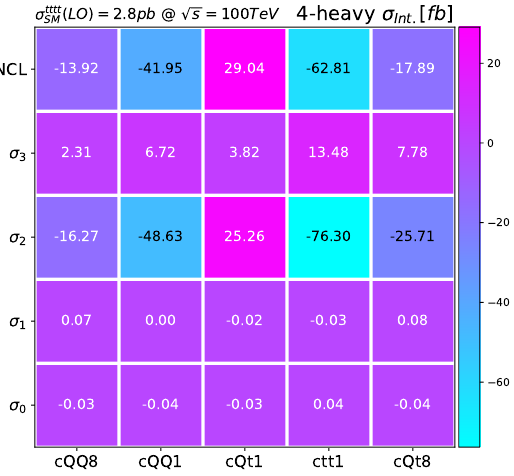
Figure 7 . Same as figure 4 but for the FCC-hh scenario. The predictions are obtained at c = 1 , √ s = 100 TeV, and Λ = 3 TeV. The SM LO cross-section at